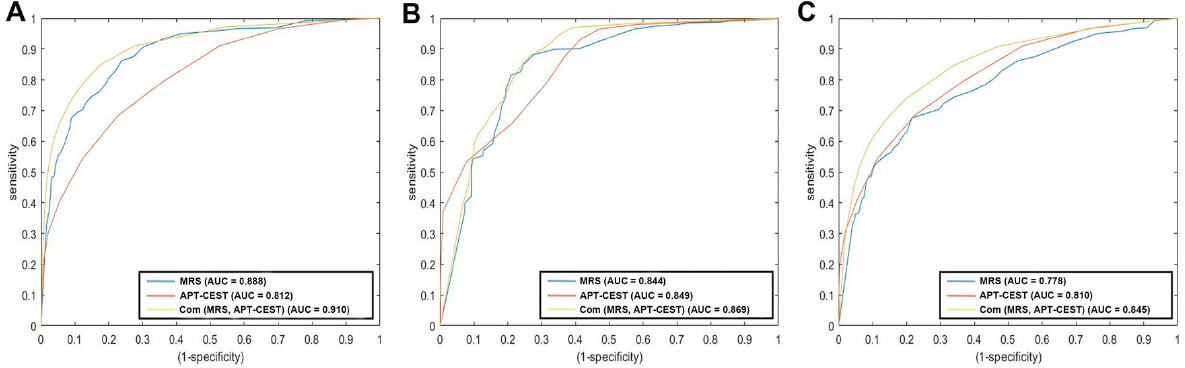
Figure 4. Voxel − wise predictions of high FET-PET signals using APT − CEST, MRS and a combination of the methods. ( A ) ROC curves in all voxels. ( B ) ROC curves of the voxels in the contrast-enhancing regions. ( C ) ROC curves of the voxels in the T2 − hyperintense regions. The x − and y − axis of the ROC (Receiver Operating Characteristics) curve were the false positive rate (FPR is known as (1 − specificity)) and the true positive rate (TPR is known as sensitivity), respectively. SUV of >1.5 for the amino acid PET scan was chosen as the positive reference in ROC curve analyses. The area under the curve (AUC) and its analysis was calculated using the method proposed by Hanley and McNeill. AUC measures the area underneath the ROC curve and varies between 0 and